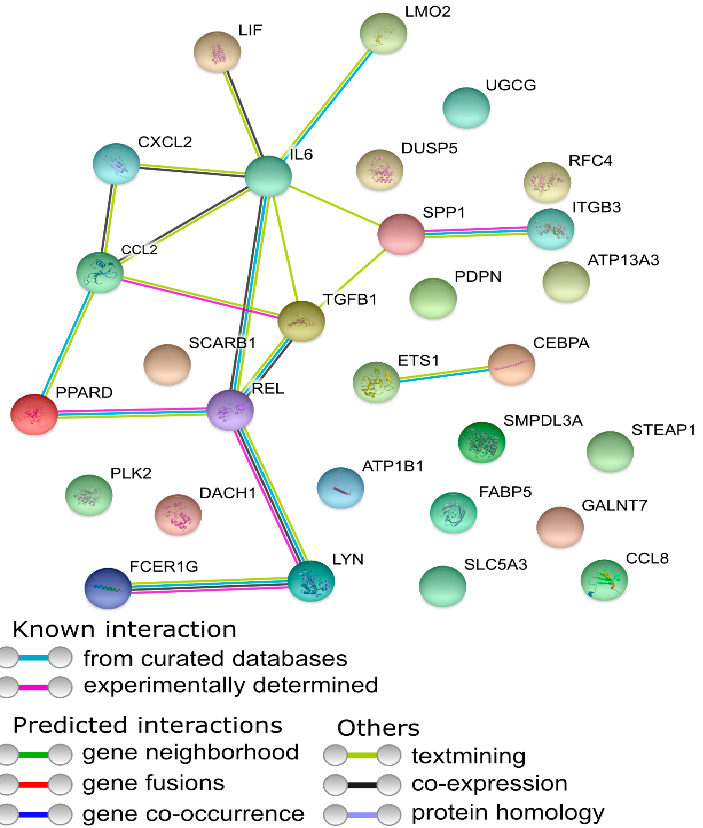
Figure 7. Search Tool for the Retrieval of Interacting Genes (STRING)-generated interaction occur- rence between gene protein products that belongs to the anatomical structure development, biological adhesion, developmental process, negative regulation of cell proliferation, regulation of cellular component organization, single − multicellular organism process, and single − organism cellular process GO BP terms. Colored nodes reference to first shell of interactors, white nodes reference to second shell of interactors.